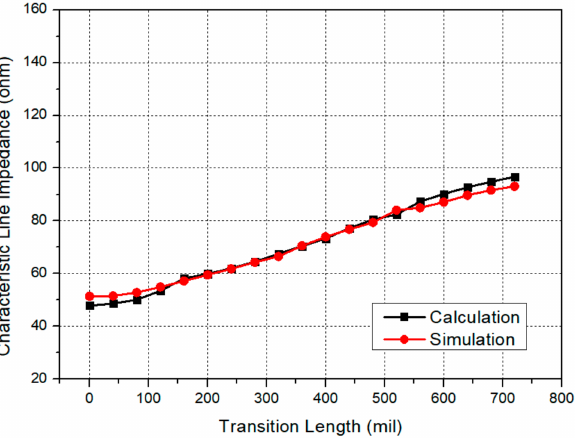
Figure 6. Calculated and simulated characteristic line impedances of the two-layered CPS-to-MSL transition without bending ( DD (cid:48) to GG (cid:48) ).